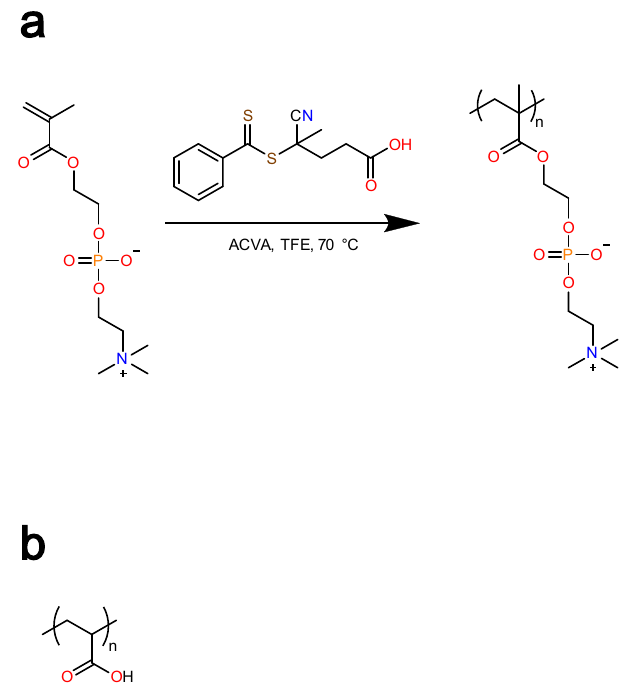
Fig. 3 Materials used in the study. 22 kDa pMPC ( a ) was synthesized from monomeric MPC, and mixed with pAA ( b ) of 50 kDa molecular weight to form